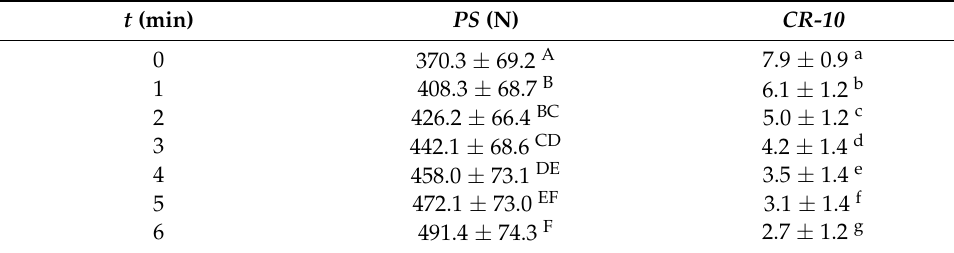
Table 1. PS and CR-10 value at recovery time for pulling